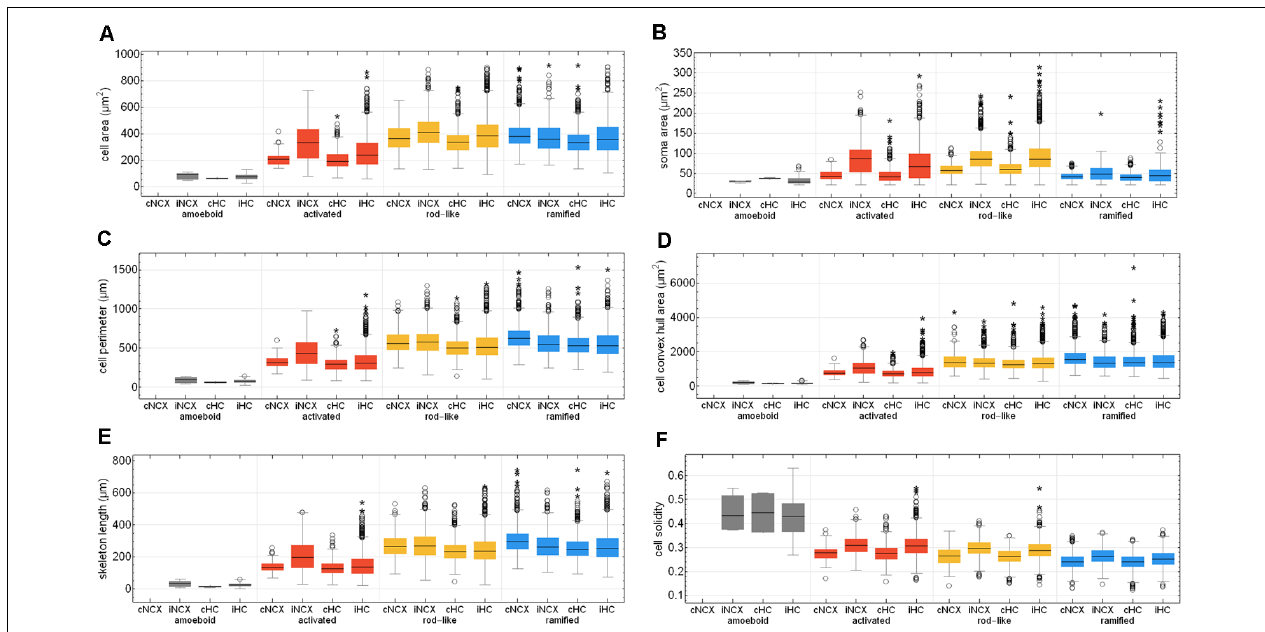
FIGURE 8 | Quantitative analysis of six morphological parameters of classified microglial cells within control and ischemic neocortex and hippocampus. Cell area (A) , soma area (B) , cell perimeter (C) , cell convex hull area (D) , skeleton length (E) , and cell solidity (F) . cNCX, control neocortex; iNCX, ischemic neocortex; cHC, control hippocampus; iHC, ischemic hippocampus. Circles represent outliers and asterisks represent extreme